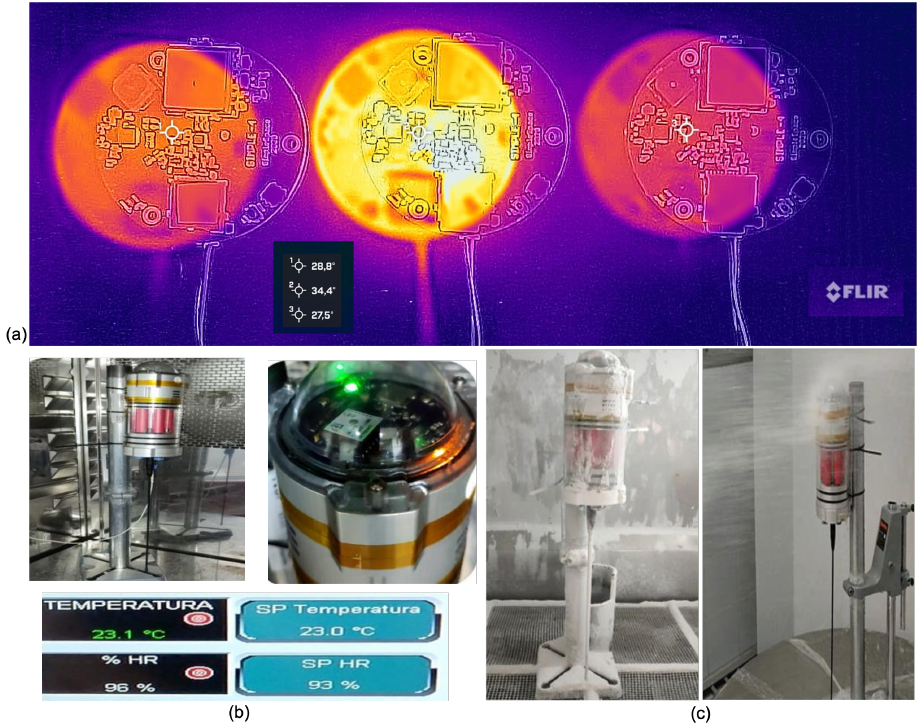
Figure 10. ( a ) Infrared thermal images under operations for different operation routines of the module. IP5X IP6X test for the device. ( b ) Temperature and Humidity stationary chamber test. ( c ) dust and wind tests.